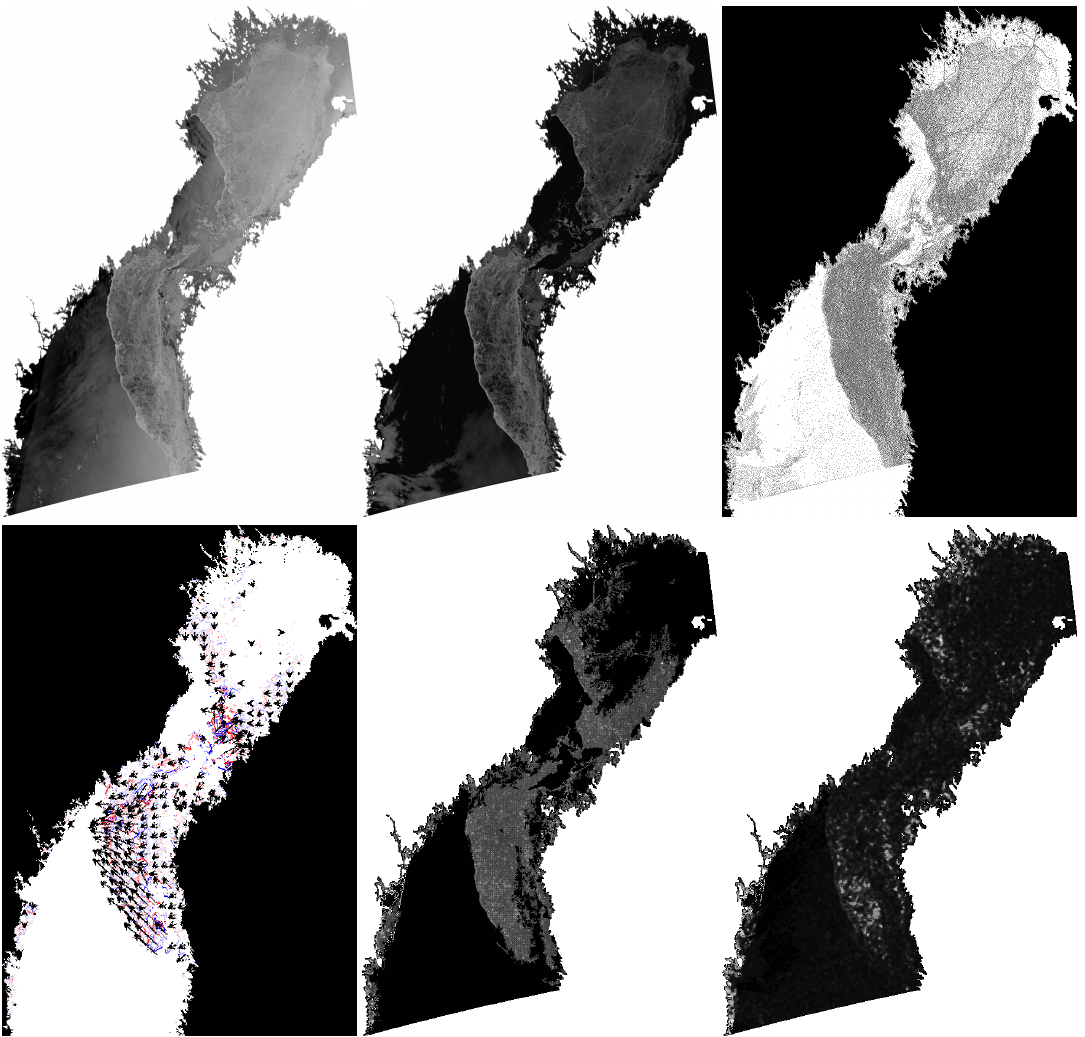
Fig. 4. The SAR images of Fig. 3 after co-registration and land masking (ASAR ©ESA, upper left, and Radarsat-2 ©MDA, upper middle), and the located edges indicating the edged areas (edges shown in black, upper right). Ice motion vector field between the SAR acquisitions on 3 April 2011 at 09:17:34UTC and 3 April 2011 at 16:12:42UTC over the Gulf of Bothnia (lower left). For better visibility, the motion vectors are shown in a coarser grid than the nominal resolution and their lengths are scaled. The longest vector corresponds to a motion of 2.83km; the maximum motion in both row and column directions was 21100m pixels. The scaled phase correlation (brighter tone indicates higher values, lower middle), and the scaled quality index Q 5 (brighter tone indicates higher values,